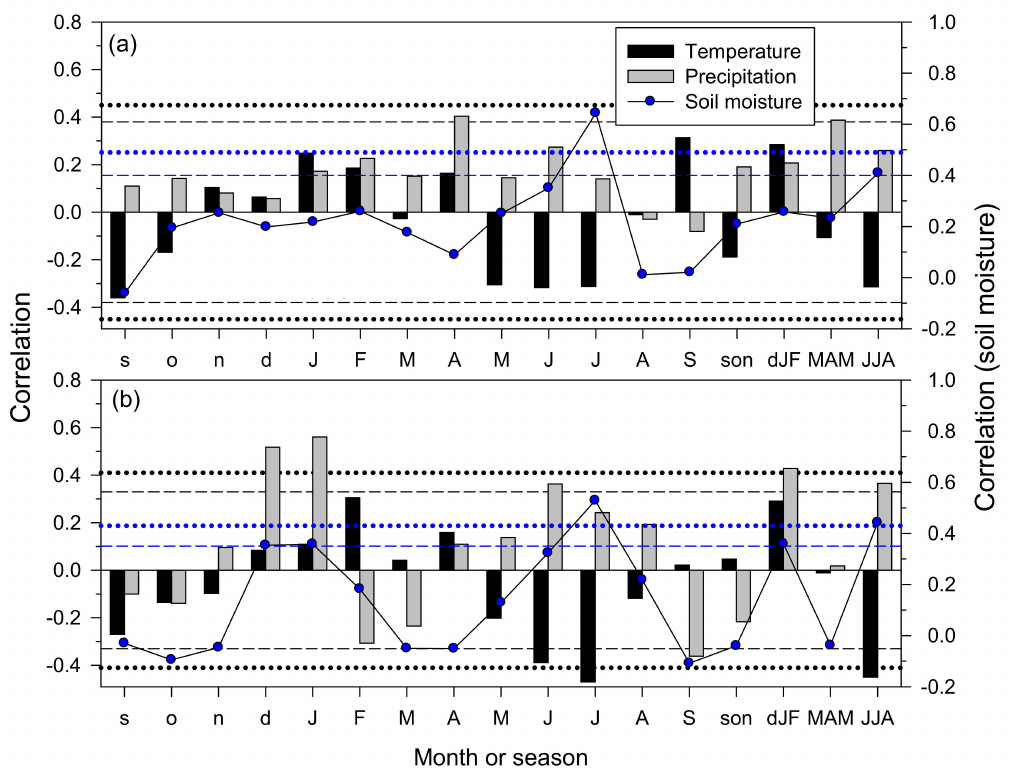
Figure 4. Monthly and seasonal climate–growth relationships of the Ephedra nebrodensis quantified at the ( a ) dry and ( b ) very dry sites. Horizontal dashed and dotted lines indicate the 0.05 and 0.01 significance levels, respectively. Note the different scales for the soil moisture (blue symbols with lines, right y -axes) and their significance levels (blue dashed and dotted lines). Months of the prior and current years are abbreviated using lowercase and uppercase letters,